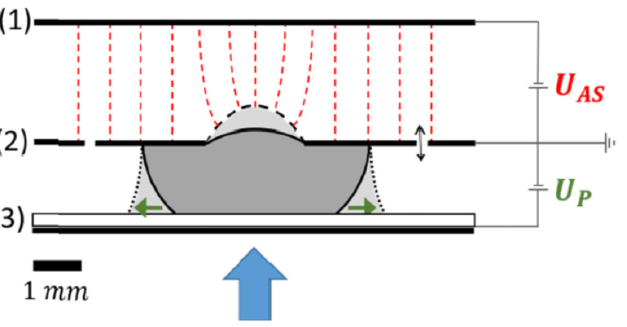
Figure 22. Joint control lens of electrowetting and Maxwell force. Schematic of the device consisting of three electrodes (1), (2), (3) with different voltages applied. [123]. Reprinted with permission from Ref. [123]. 2019 The Optical Society.